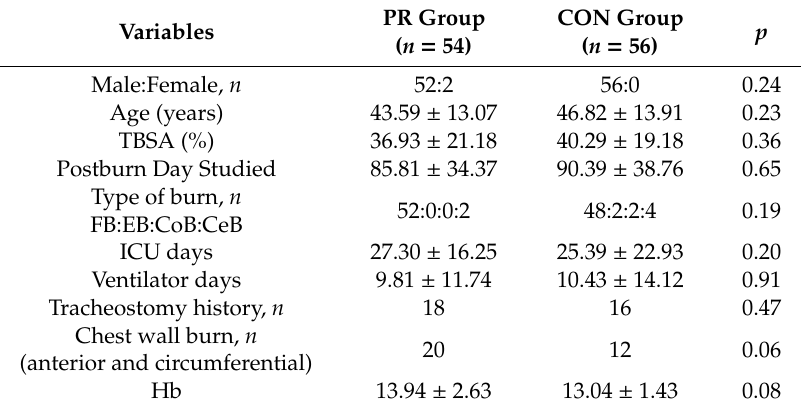
Table 1. Demographic and Clinical Characteristics of Subjects.